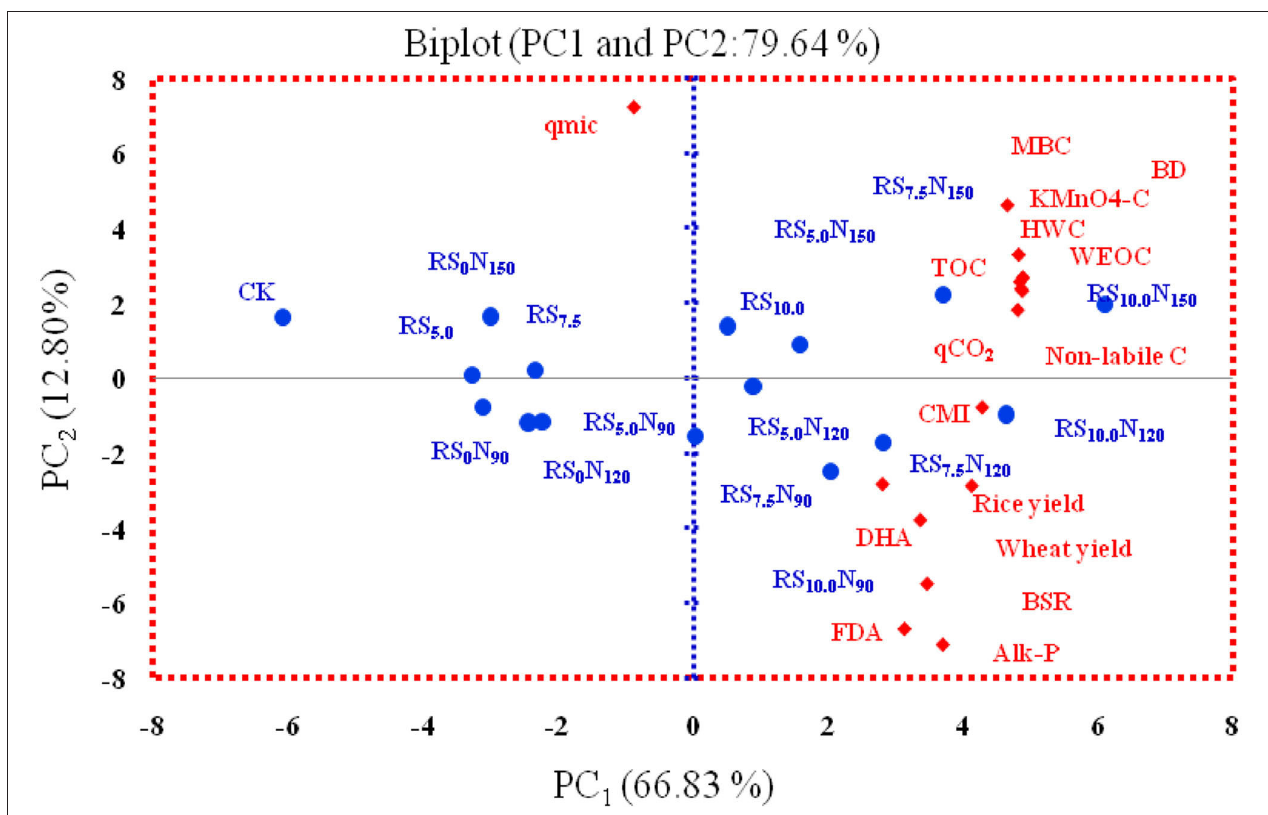
FIGURE 5 | Biplots of Principal Component Analysis (PCA) using variables and field treatments for explaining variability in the data-set using principle components (PCs) (DHA, Dehydrogenase activity; FDA, Fluorescein diacetate activity; Alk-P, Alkaline phosphatase activity; TOC, Total organic carbon; KMnO 4 -C, Potassium permanganate oxidizable carbon; WEOC, Water extractable organic carbon; HWC, Hot water carbon; MBC, Microbial biomass carbon; BSR, Basal soil respiration; qCO 2 , Microbial quotient; Qmic, Metaboloic quotient; B D , Bulk density; N, Fertilizer-N and RS, Rice